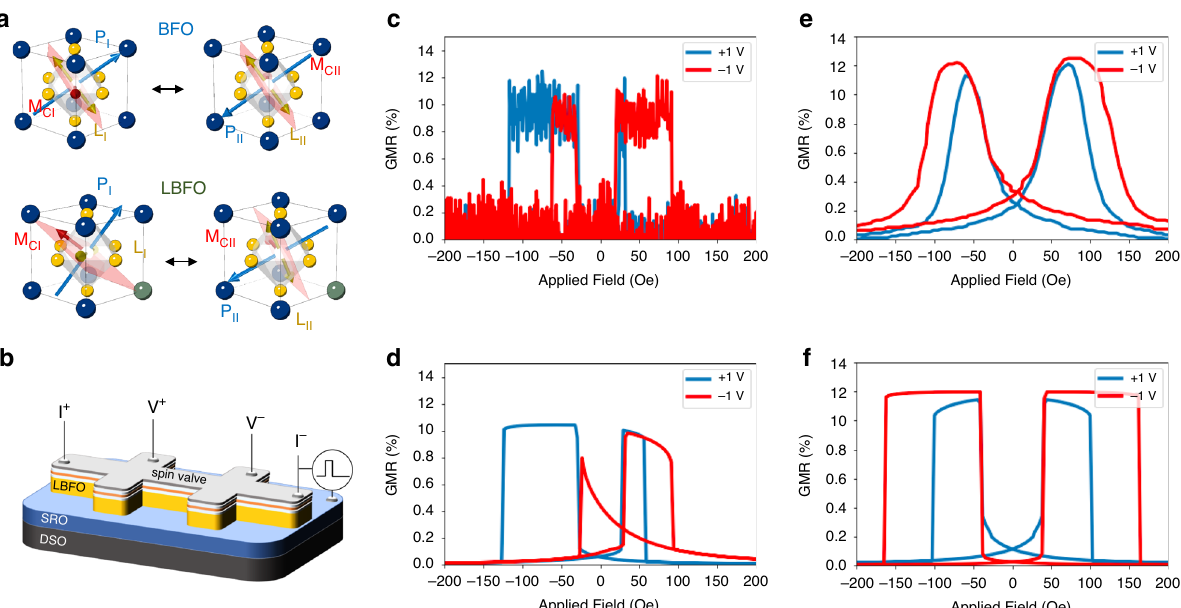
Fig. 5 Magnetic anisotropy switching by electric fi eld via the heterostructure of spin-valve/BiFeO 3 (Bi 0.85 La 0.15 FeO 3 ). a Schematics for the different electrically polarized states of P , L , and M C in BiFeO 3 and Bi 0.85 La 0.15 FeO 3 . b Schematic for magnetoresistance measurements on spin-valve/BiFeO 3 (Bi 0.85 La 0.15 FeO 3 ) heterostructure. c R(H) of spin-valve/BiFeO 3 on the different electrically polarized states. d micromagnetic simulations on R(H) of spin- valve/BiFeO 3 with different polarization states. e R(H) of spin-valve/ Bi 0.85 La 0.15 FeO 3 on the different electrically polarized states. f Micromagnetic simulations on R(H) of spin-valve/ Bi 0.85 La 0.15 FeO 3 with different polarization